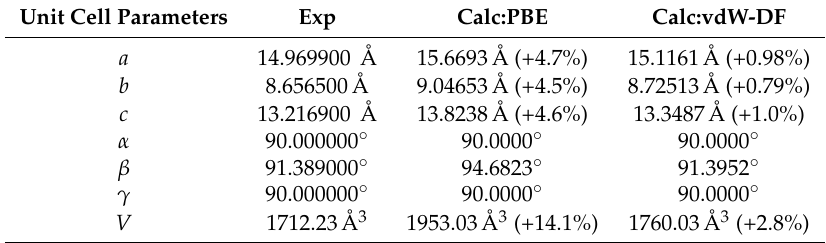
Table 2. Unit cell parameters of κ -AgCN obtained from X-ray diffraction measurements at 150K (left column), ab initio calculations based solely on PBE functional (central column) and on vdW-DF functional (right column). Relative deviations from experimental values are given in parentheses.